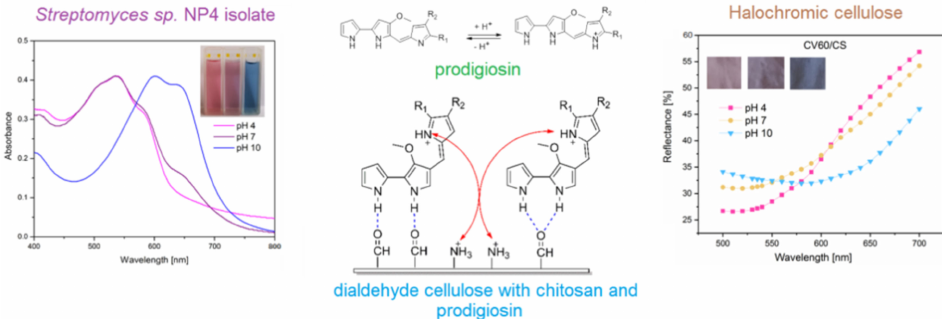
Figure 11. Schematic representation of interaction between oxidized viscose (dialdehyde cellulose) and deposited chitosan and color-changing prodigiosin isolate to obtain pH-sensitive color-changing fabric (reprinted with permission from reference [32] Copyright 2021